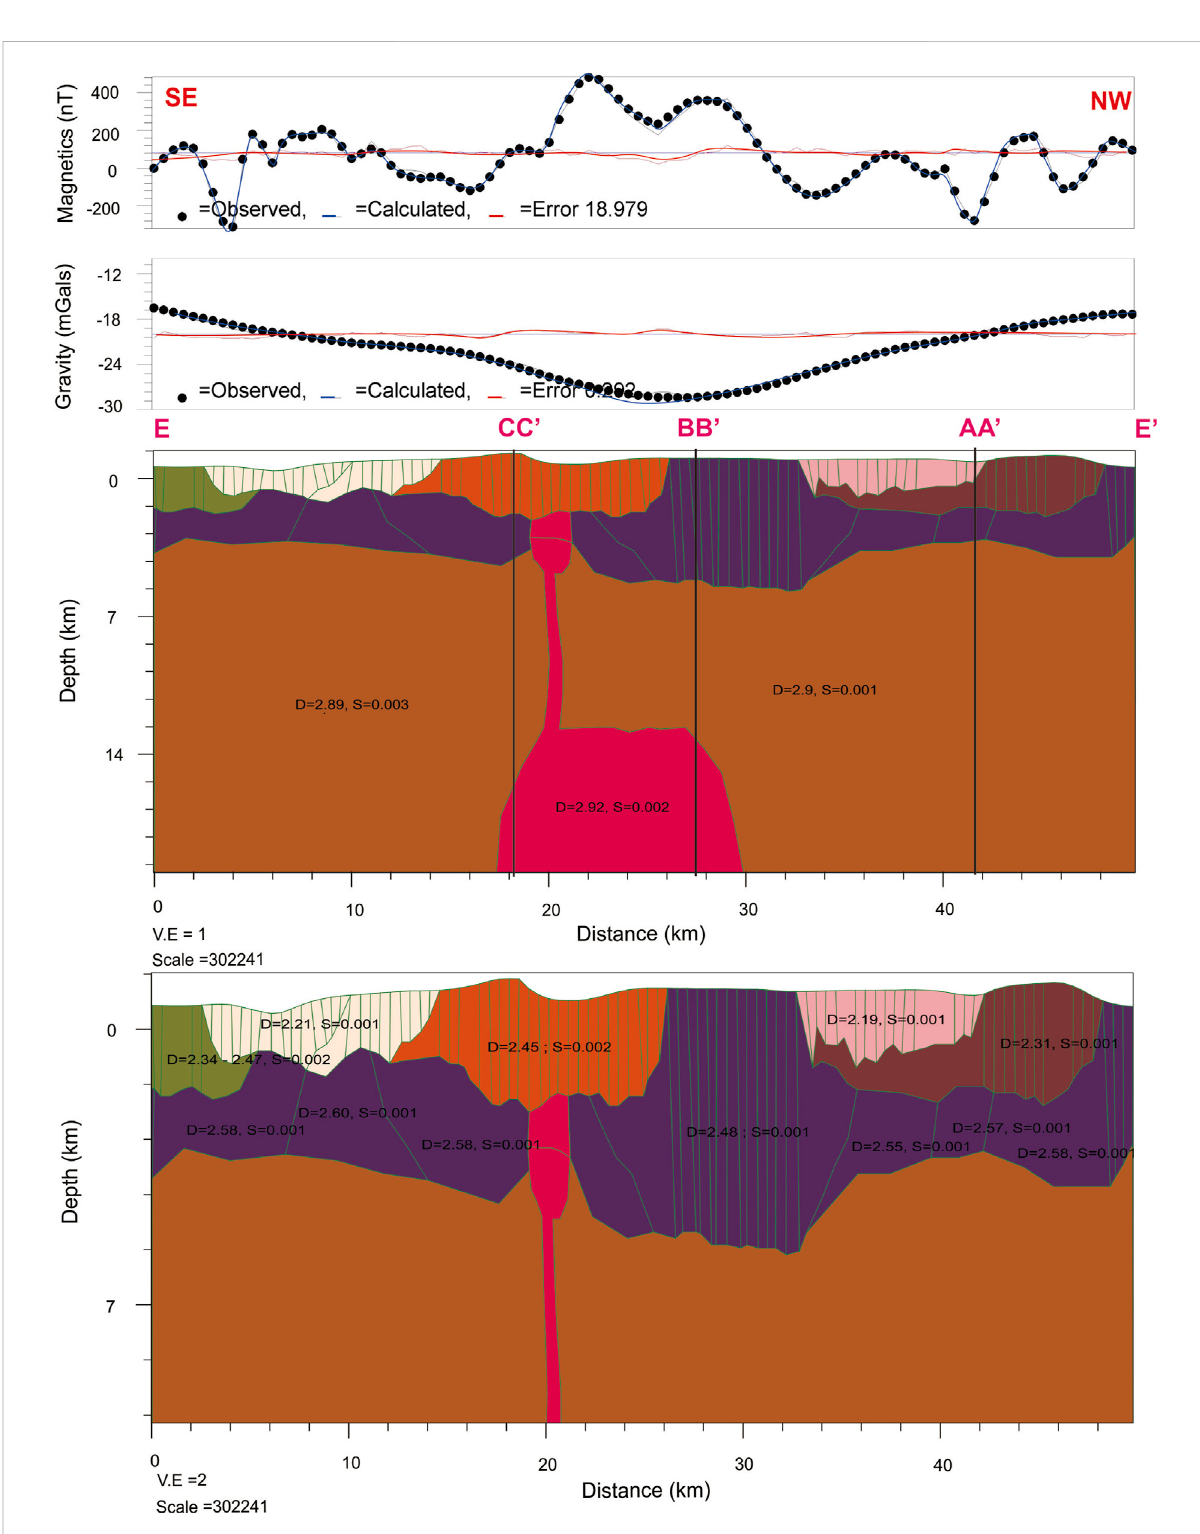
FIGURE 7 2D modeling of magnetic and gravity data of the E-E ′ pro fi le in the Sianok segment of GSF showing the shallow and deep magma chambers of Mount Singgalang Tandikat. This segment passes different surface lithologies (Qamj, Qpt, Ps, Qast, and Qama), causing variation in the measured surface magnetic anomalies. As presented in Table 1, these surface lithologies vary in their average magnetic susceptibilities. See the text for details. This fi gure uses the same legend as that in Figure 3.